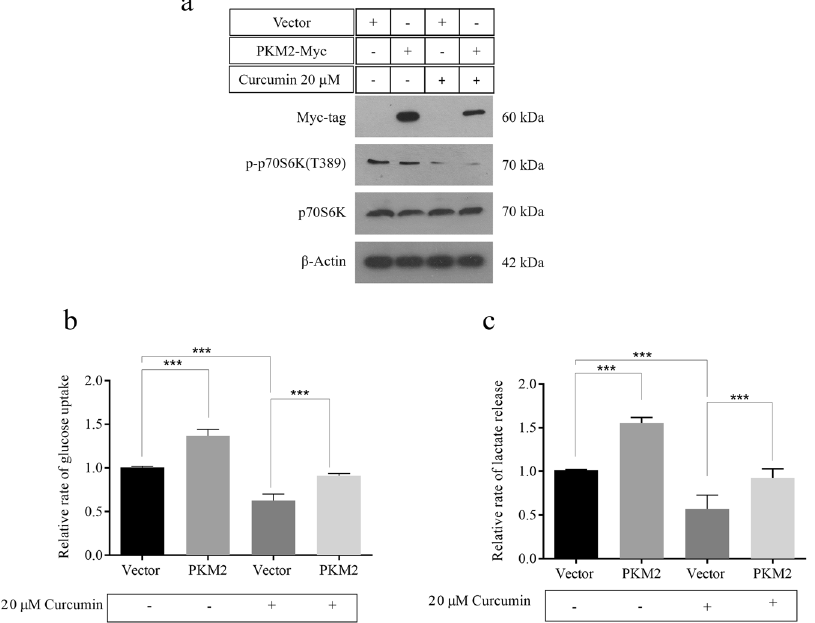
Figure 5. PKM2 over-expression reversed the effects of curcumin on cancer glycolysis. ( a ) Immunoblot confirming myc-PKM2 over-expression in H1299 cells continually exposed to 20 μ M curcumin. Nearly diminished p-p70SK (T389) in both vector and PKM2 transfected H1299 cells confirmed mTOR inhibition by curcumin. Increased glucose uptake ( b ) and lactate release ( c ) in H1299 cells over-expressing PKM2, compared to vector transfected, in absence and presence of